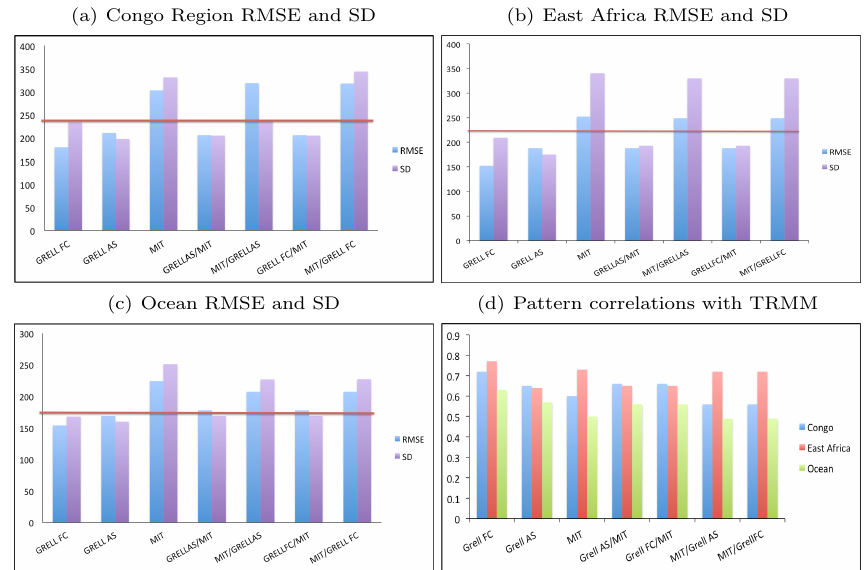
Figure 3. Precipitation statistical evaluation for performance of the different cumulus schemes over the different regions: ( a ) root mean square errors (RMSE) and standard deviation over the Congo Region, ( b ) same as ( a ) but for the East Africa region, ( c ) same as ( a ) but over the ocean, and ( d ) pattern correlation coefficients for the different simulations with the TRMM observational data during the Short Rains in